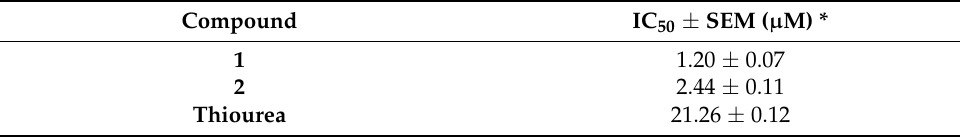
Table 6. In vitro urease inhibitory activity of compounds 1 and 2 .